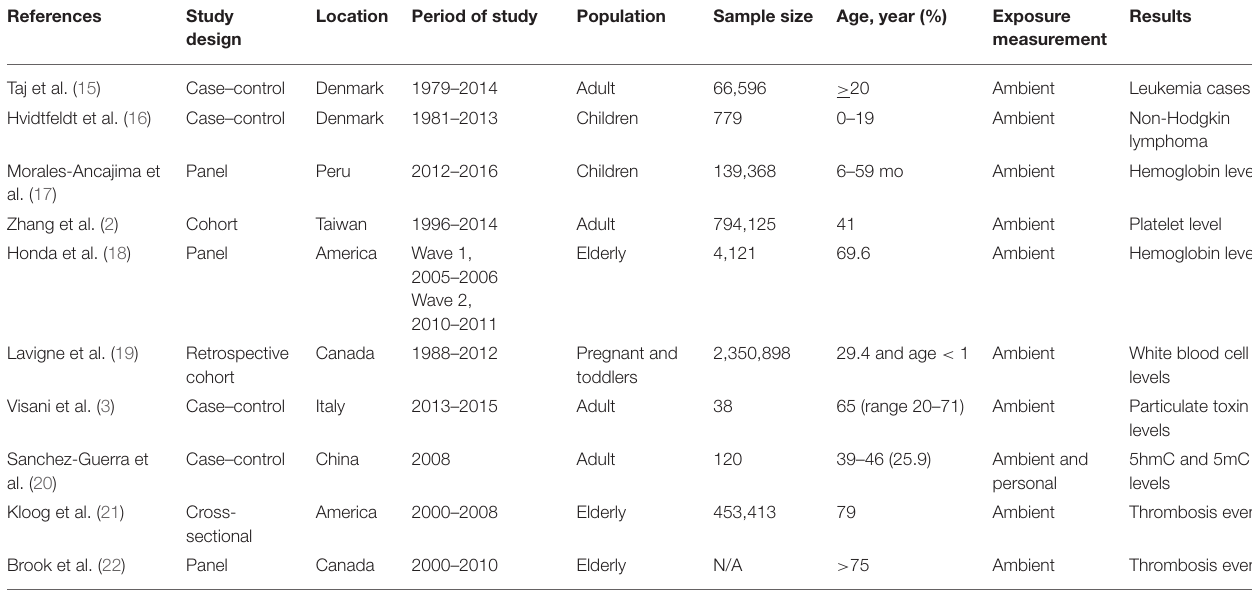
TABLE 1 | Characteristics of included studies.